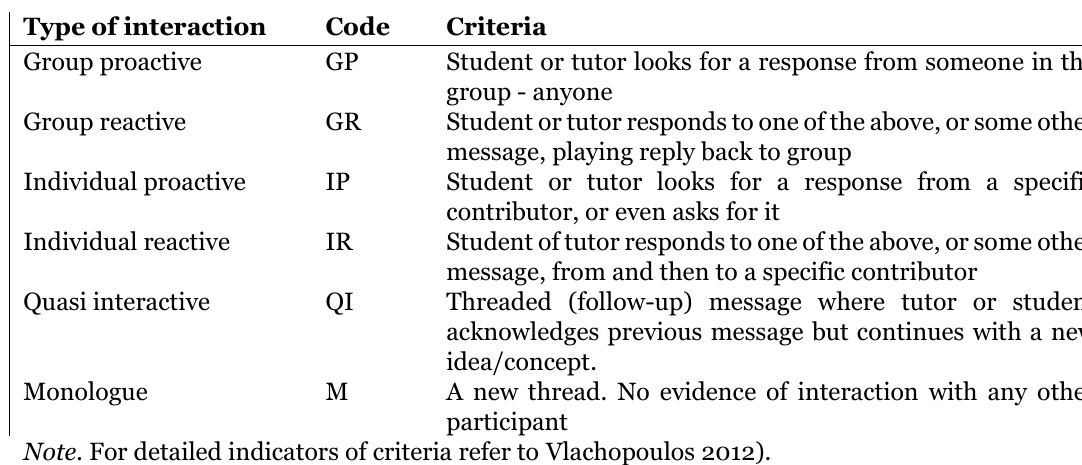
Interaction Coding Scheme Type of